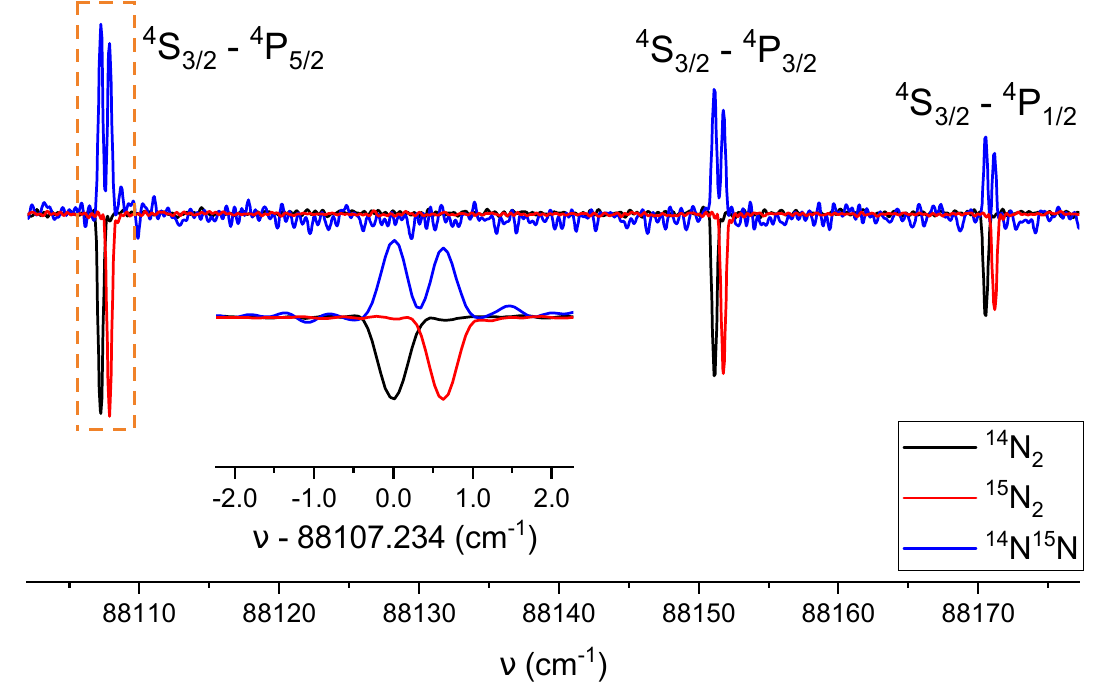
Figure 2. Overview spectra of N I core changing transitions 4 S 3/2 – 2 s 2 p 4 4 P J excited from the ground state, using different isotopic parent gases. The inset presents the 4 S 3/2 – 2 s 2 p 4 4 P 5/2 line exhibiting a well-resolved isotopic shift. Note that all spectra were measured in